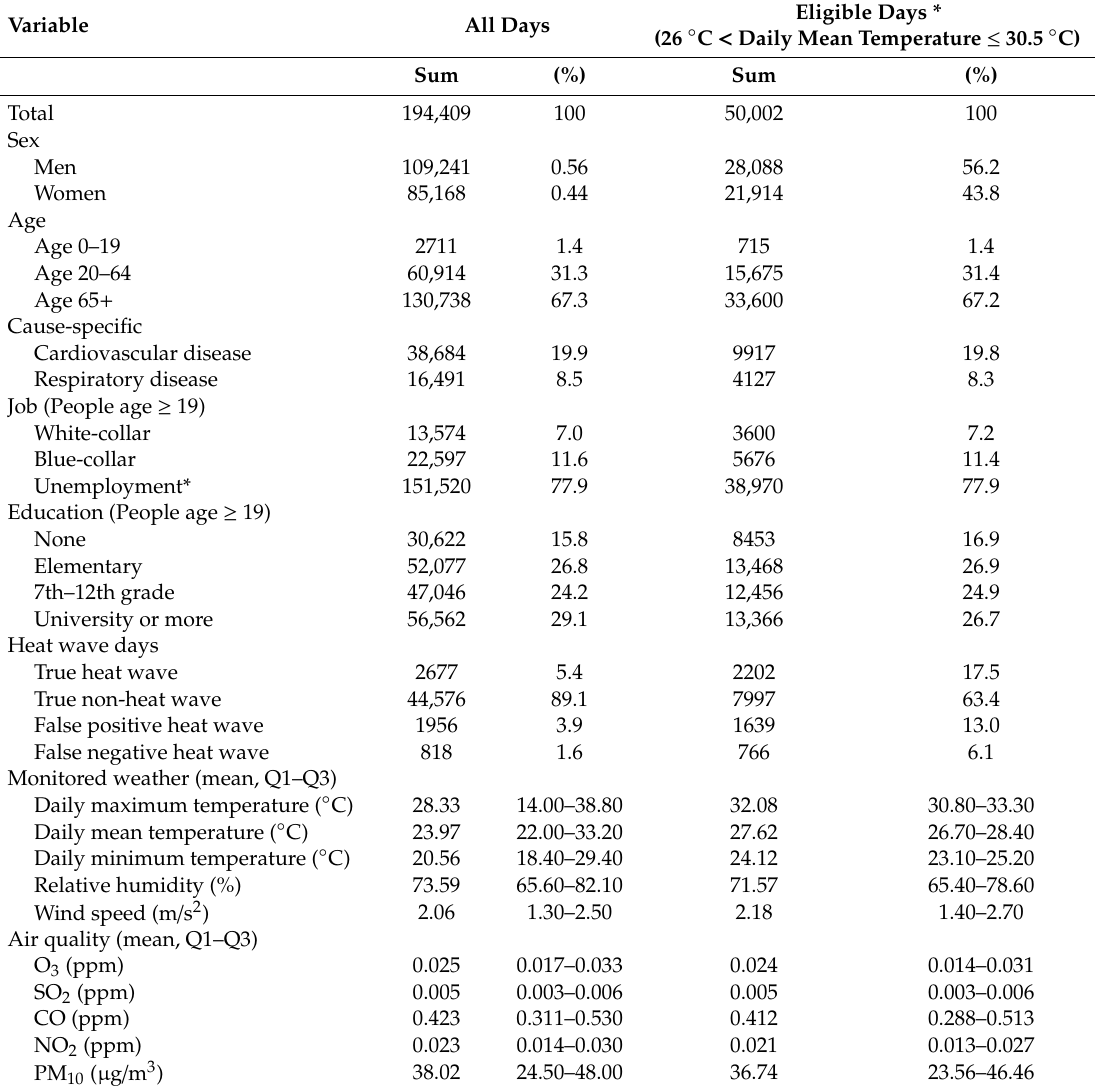
Table 2. Characteristics of mortality, heat wave, weather and air quality data